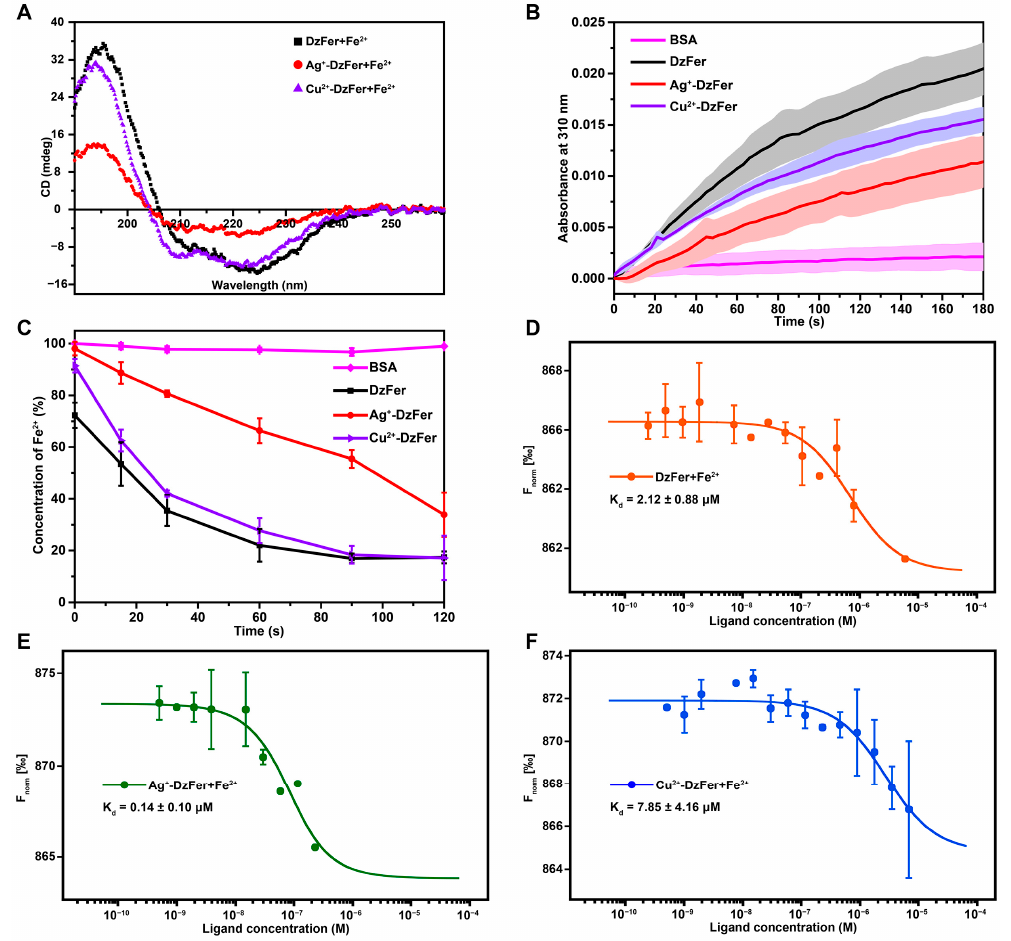
Figure 8. ( A ) Far-UV CD spectra underlying the secondary structure changes in DzFer, Ag + -DzFer, and Cu 2+ -DzFer after Fe 2+ ion uptake. ( B ) The progress curves of the oxidation of Fe 2+ into Fe 3+ ion related by BSA, DzFer, Ag + -DzFer, and Cu 2+ -DzFer were monitored at 310 nm at room temperature. Solid lines indicate the average of three technical replicates, and shaded areas represent the standard deviation (SD) from the mean. ( C ) The concentration of Fe 2+ was detected based on monitoring the absorbance of the ferrozine–Fe 2+ complexes at 560 nm. Experiments were performed independently in triplicate ( n = 3), and the data were reported as mean ± SD. Representative MST fitting curves of Fe 2+ ion binding to DzFer ( D ), Ag + -DzFer ( E ), and Cu 2+ -DzFer ( F ) proteins. Error bars represent the range of data points obtained from three independent measurements.